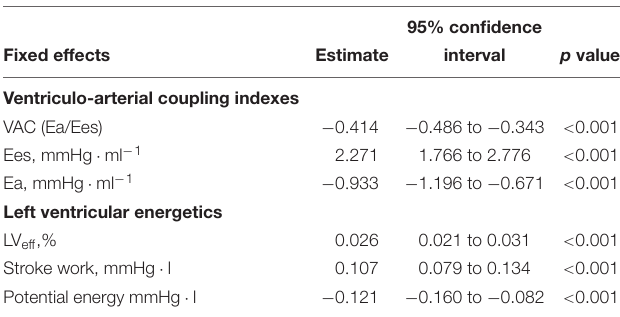
TABLE 6 | Relationship between ventriculo-arterial coupling and left ventricular efficiency and Ea dyn according to a mixed-effect regression